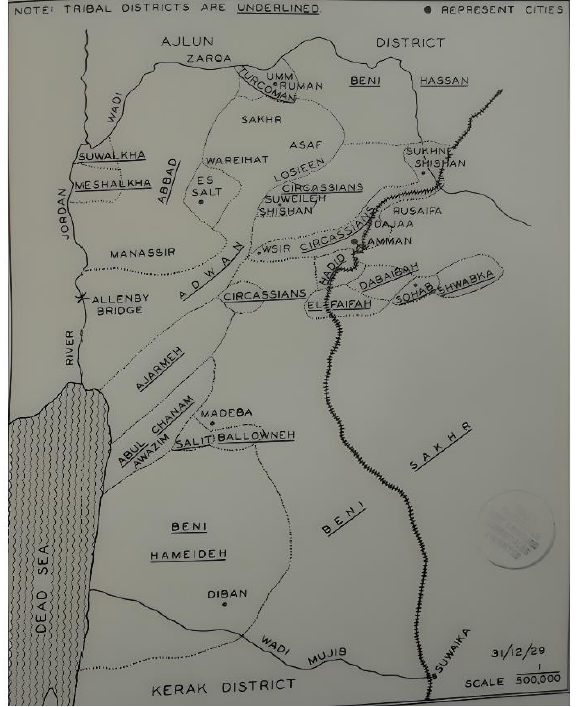
Figure 1. Tribal map of the Balga District, Jordan—Adapted from Peake (1958, p. 253).